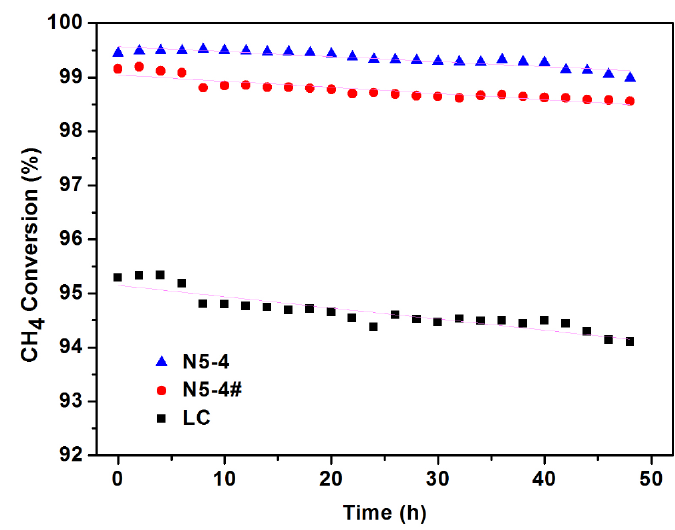
Figure 13. The stability test of LC, LC-SH-4, and LC-SH-4#. Table 5. BET results of LC, LC-SH-4, and LC-SH-4# (fresh and used).